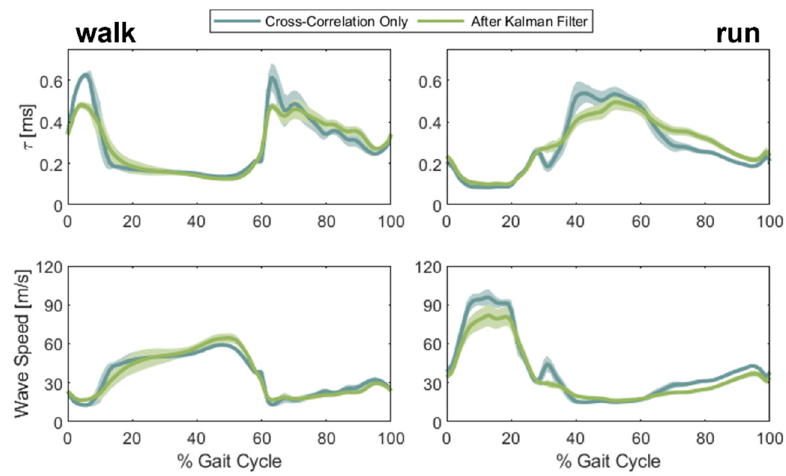
Figure 11. Walking and running data for one subject processed with only the cross-correlation method (blue) and then with the Kalman filter method (green), with one standard deviation above and below highlighted. Application of the Kalman filter resulted in overall lower measured variability both between strides and across the stance and swing phases of gait.